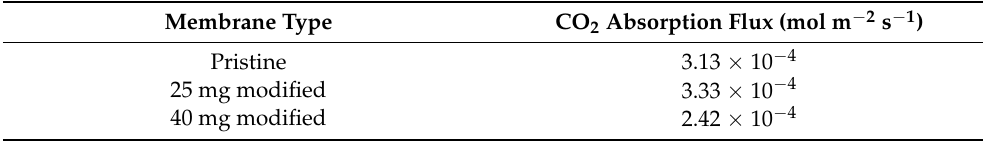
Table 5. Highest CO 2 absorption flux over the total runs of the selected membrane